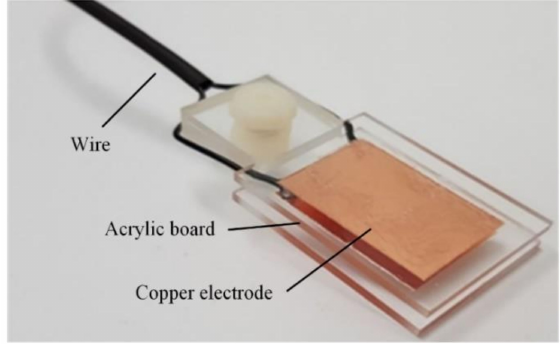
Figure 2. Photo of the sensor structure.